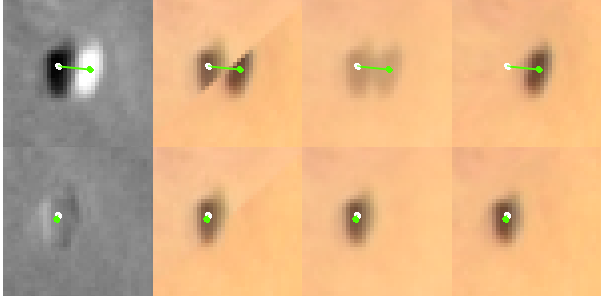
Fig. 4 Correspondence tool. Top: tool applied to the first row of Fig. 2. Bottom: result of data-based optimization incorporating the